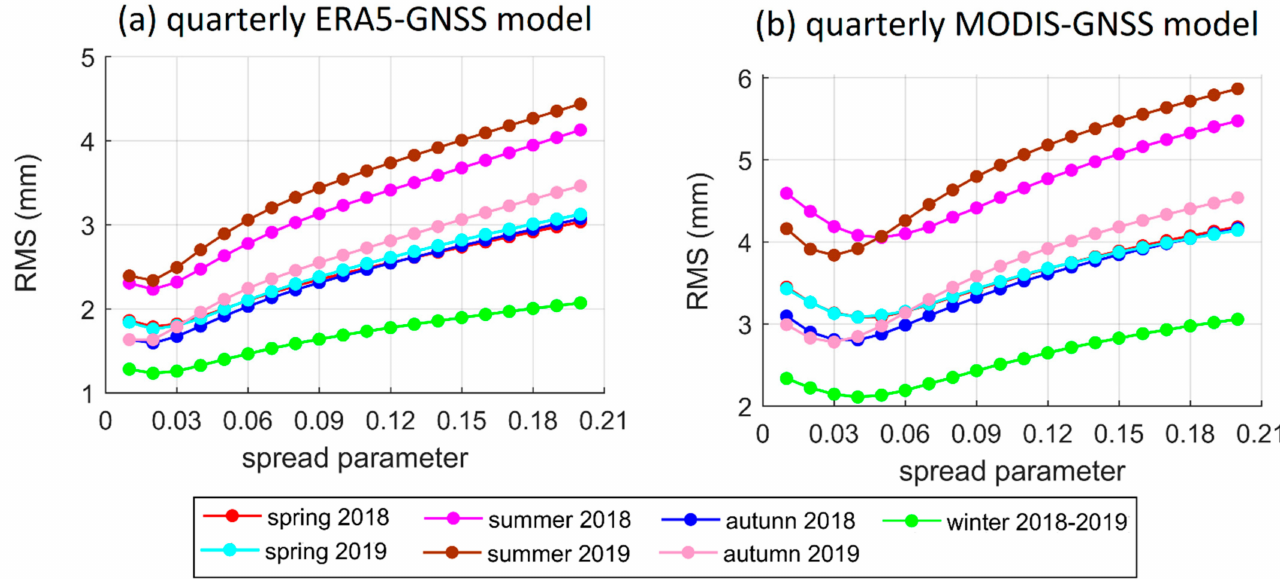
Figure A2. Quarterly model performance against spread parameter